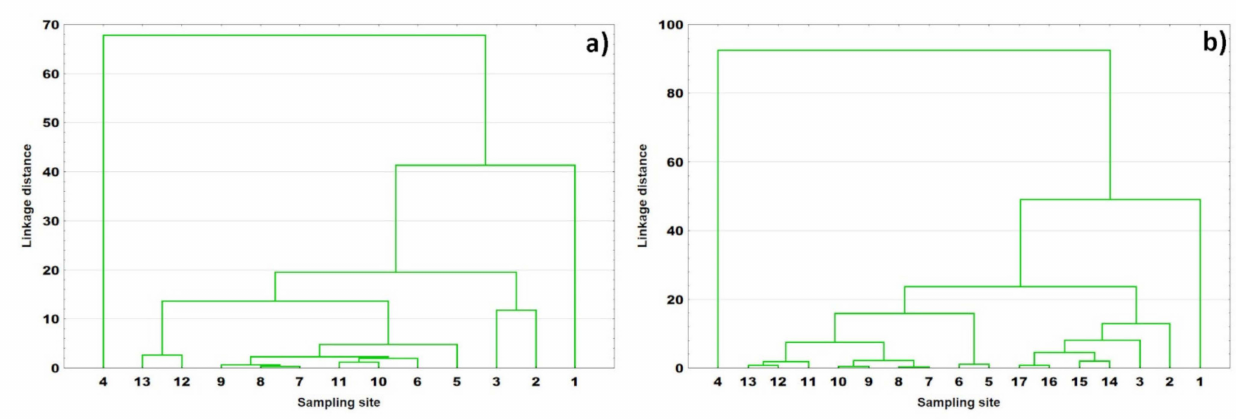
Figure 7. Dendrograms showing clustering of sampling sites in ( a ) 2018 and ( b )